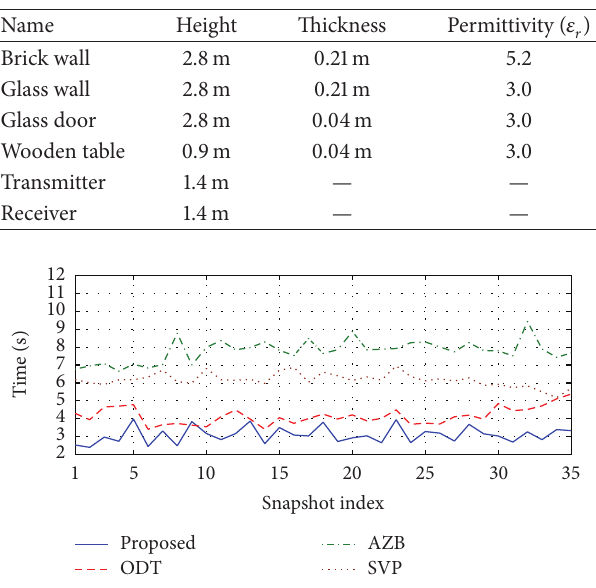
Table 2: Specifications of the simulation environment.